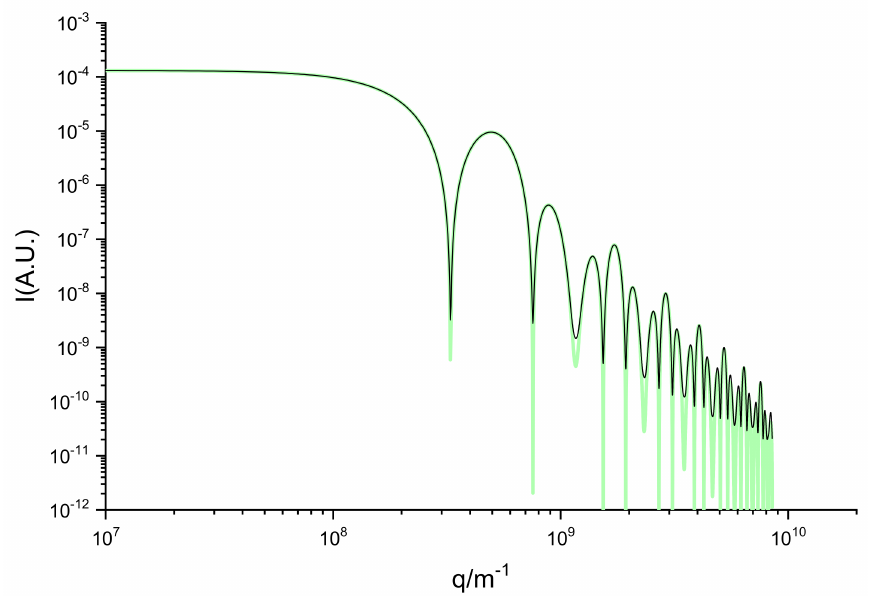
Figure 2. Comparison of the analytical (thick green line) and computed (black thin line) intensity spectra (as a function of scattering-vector magnitude q) of the electron distribution described in the Section 3.